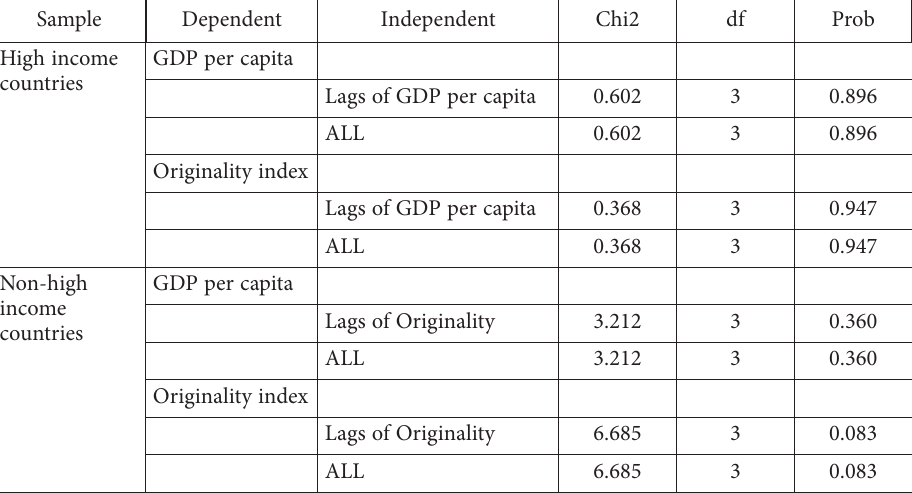
Table C.2. Granger causality test results for GDP per capita and originality index